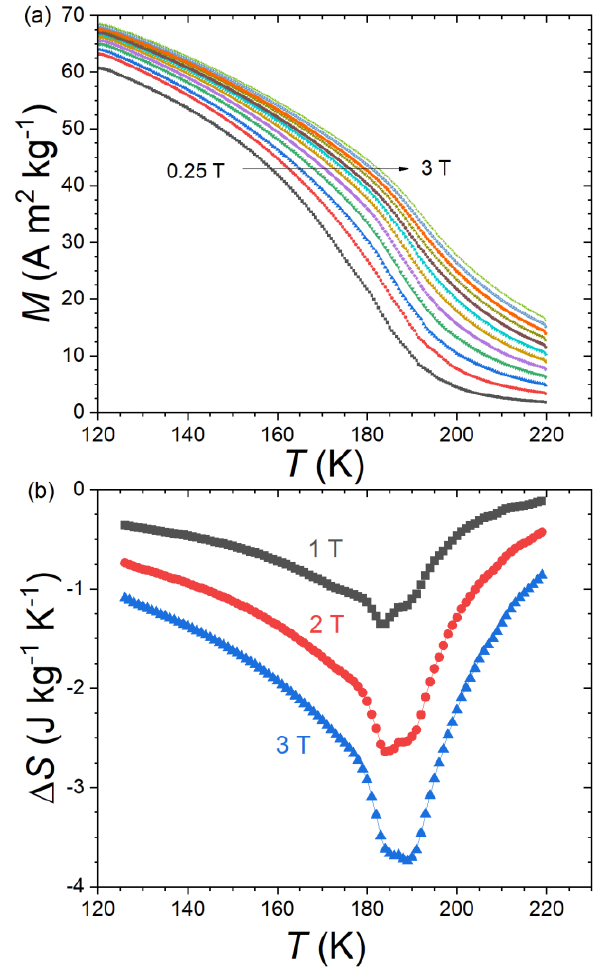
Figure 7. Magnetocaloric effect of MnFe 0.53 Ni 0.47 Si 0.94 Al 0.06 quenched from 1100 ◦ C: ( a ) M ( T ) curves recorded upon heating in different magnetic fields (heating rate = 1 K min − 1 ); ( b ) isothermal entropy change calculated from M ( T ) curves upon